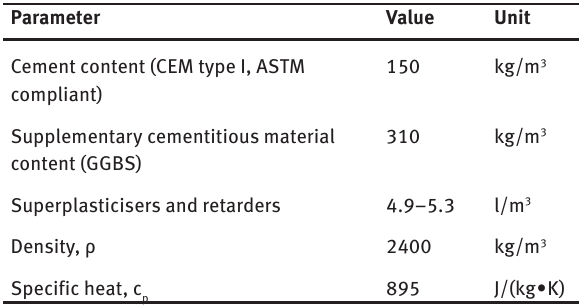
Table 1: Measurement levels.